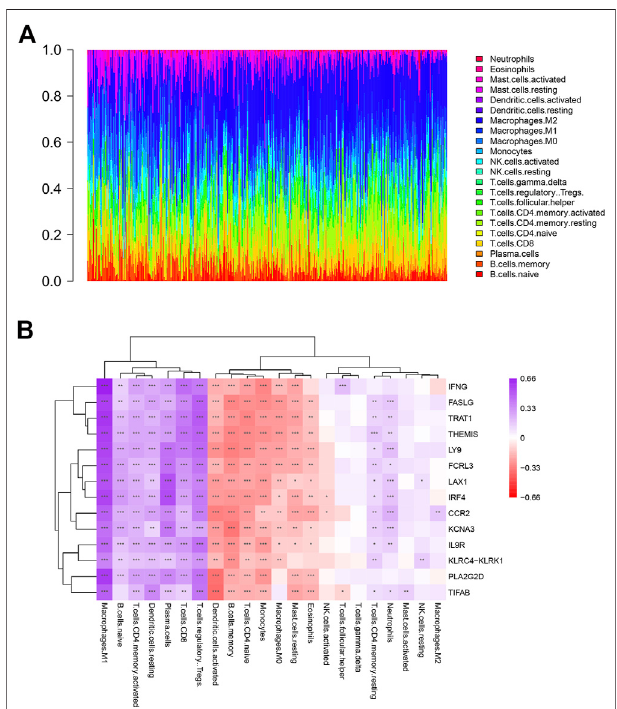
FIGURE 6 | Pro fi le of immune cells in OV and correlation analysis between genes and immune cells. (A) The proportion of 22 kinds of immune cells in ovarian tumor samples. (B) Correlation analysis between the expression of key genes and immune cells